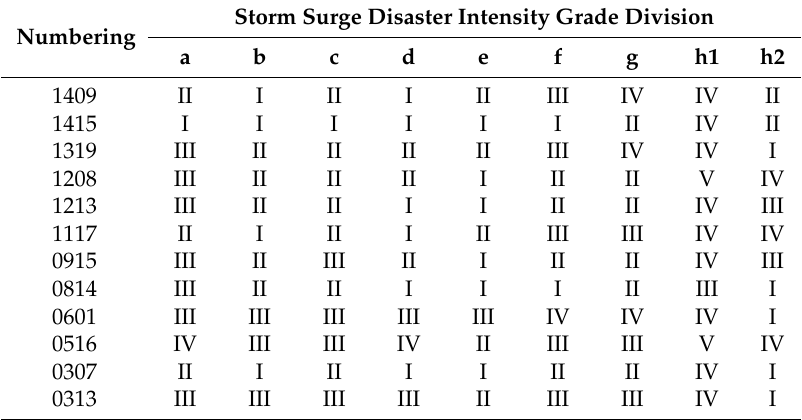
Table 5. Classification of storm surge